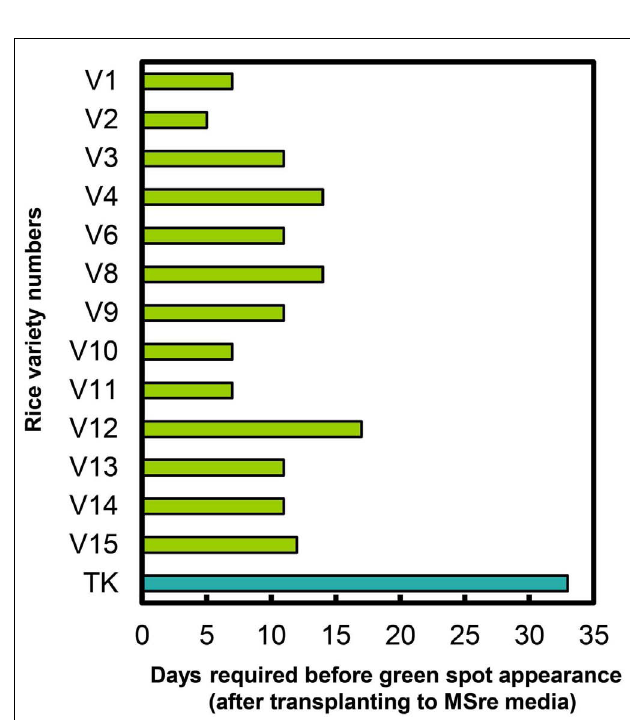
FIGURE 4 | Durations of time required for green spot appearance in Myanmar rice varieties and in the varietyTsukinohikari .V1–V15 on vertical bar represent the variety numbers described in Table 1 andTK meansTsukinohikari. Durations of time from transfer to MSre media to green spot appearance are indicated. Regenerated plants were obtained from these green spots.